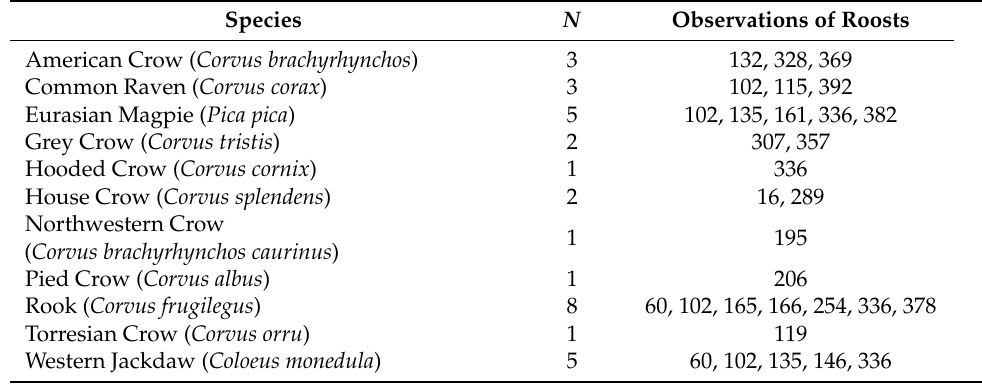
Table 5. List of articles reporting roosting corvids in urban areas ( n = 23). The reference numbers in the table refers to the individual publication numbers given in Table S2.